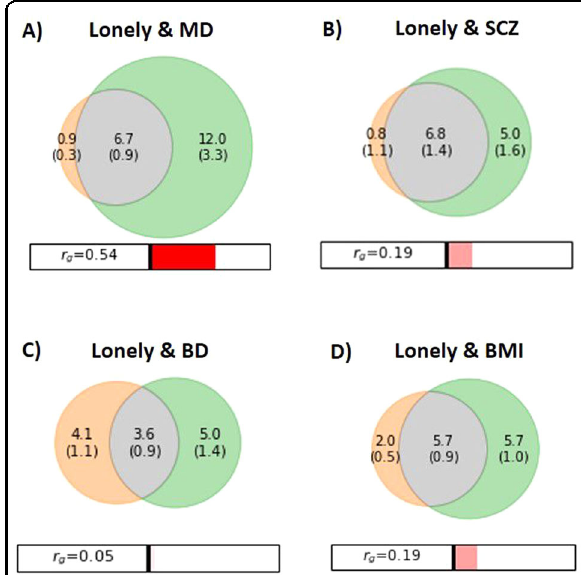
Fig. 1 Venn diagrams of unique and shared polygenic variants. Venn diagrams showing polygenic overlap (gray) between A ) loneliness (orange) and major depression (MD) (green), B ) schizophrenia (SCZ) (green), C ) bipolar disorder (BD) (green), and D ) body mass index (BMI) (green). The numbers indicate the estimated quantity of causal variants (in thousands) per component, explaining 90% of SNP heritability in each phenotype, followed by the standard error. The size of the circles re fl ects the degree of polygenicity. Figures generated from